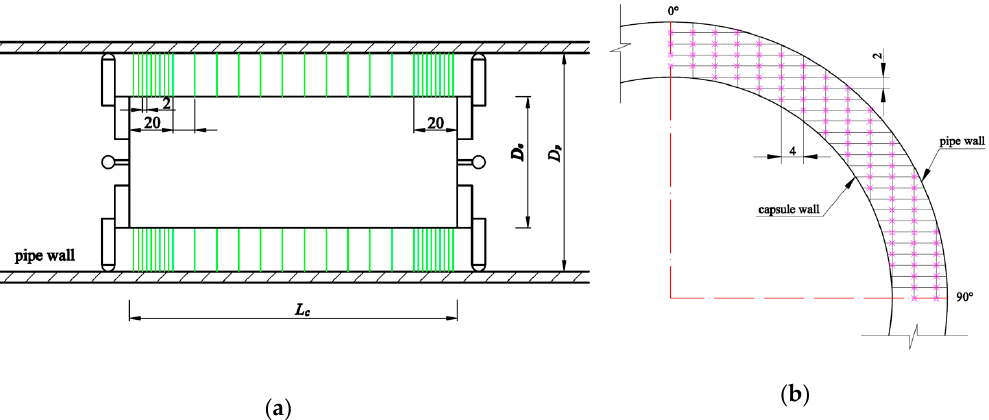
Figure 5. Flow-field measuring-point layout. ( a ) Test section of flow field; ( b )Measuring points for each section; (1/4 of the test section).